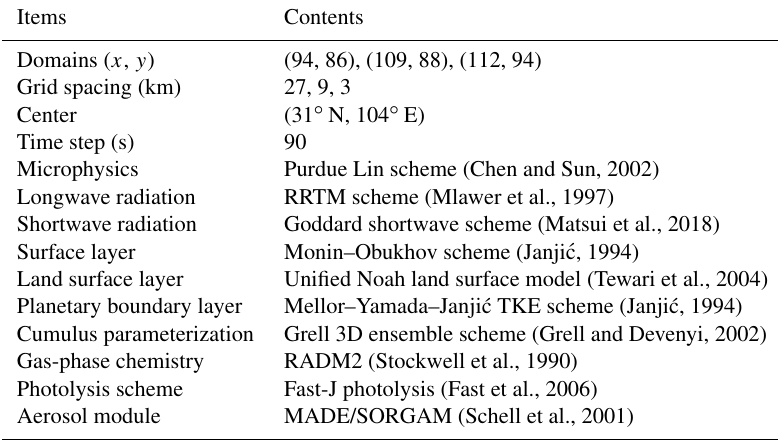
Table 1. The domains and main options for WRF-Chem.